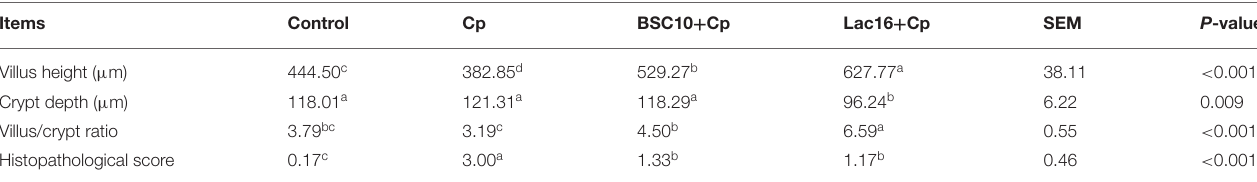
TABLE 2 | The ileal histomorphology of broilers infected with C. perfringens